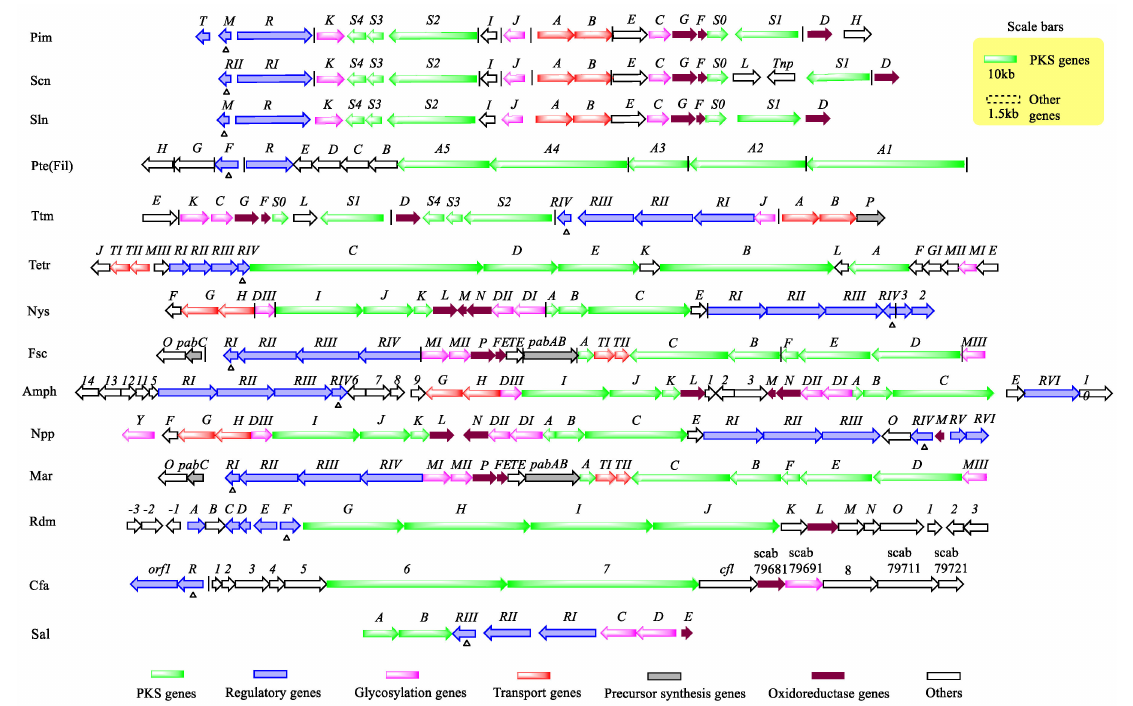
Figure 2. Biosynthetic gene clusters containing the PAS-LuxR genes. Sln is a biosynthetic gene cluster that produces pimaricin in S.gilvosporeus . Scn is a biosynthetic gene cluster that produces pimaricin in S. chattanoogensis . Pim is a biosynthetic gene cluster that produces pimaricin from S. natalensis . Ttm is a biosynthetic gene cluster that produces tetramycin from S. ahygroscopicus . Tetr is a biosynthetic gene cluster that produces tetramycin from S. hygrospinosus . Nys is a biosynthetic gene cluster for the production of nystatin by S. noursei , Amph is a biosynthetic gene cluster that produces amphotericin from S. nodosus . Fsc is a biosynthetic gene cluster for the production of candicidin by S. sp. FR-008. Pte (Fil) is a biosynthetic gene cluster producing filipin from S. avermitilis ( S. filipinensis ). Cfa is a biosynthetic gene cluster for the production of CFA-L-Ile by S. scabiei . Rdm is a biosynthetic gene cluster that produces reedsmycins from S. sp. CHQ-64. Npp is a biosynthetic gene cluster that produces NPPA1 from P. autotrophica . Mar is a biosynthetic gene cluster that produces PF from S. marokkonensis M10. Sal is a biosynthetic gene cluster that produces salinomycin from S. albus . The symbol of ∆ and | represent PAS-LuxR regulators coding genes and binding